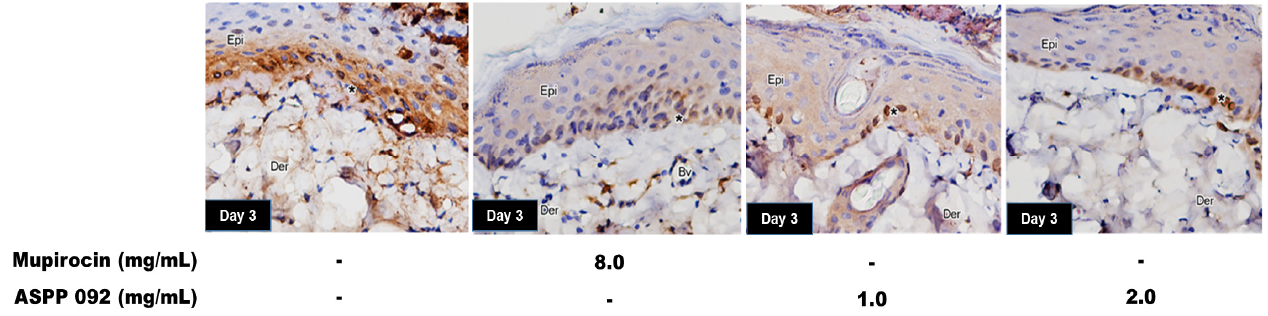
Figure 5. COX-2 expressions in the experimentally induced wounds treated with ASPP 092. The experimentally induced wounds were treated with either mupirocin or ASPP 092 at concentrations of 1 mg/mL and 2 mg/mL. A vehicle control group was also maintained. Immunohistochemistry analysis was conducted to estimate the COX-2 expressions in the experimental wounds. Immunos- taining for COX-2 (dark brown nuclei) in the epidermis and dermis of rat skin wounds on day 3 is represented. The density of COX-2 positive cells on stratum basale and lower part of stratum spinosum, fibroblasts, and endothelial cells of new vessels are also shown (Bv, blood vessel; Der, dermis; Epi, epidermis; *, inflammatory cell; ×200).